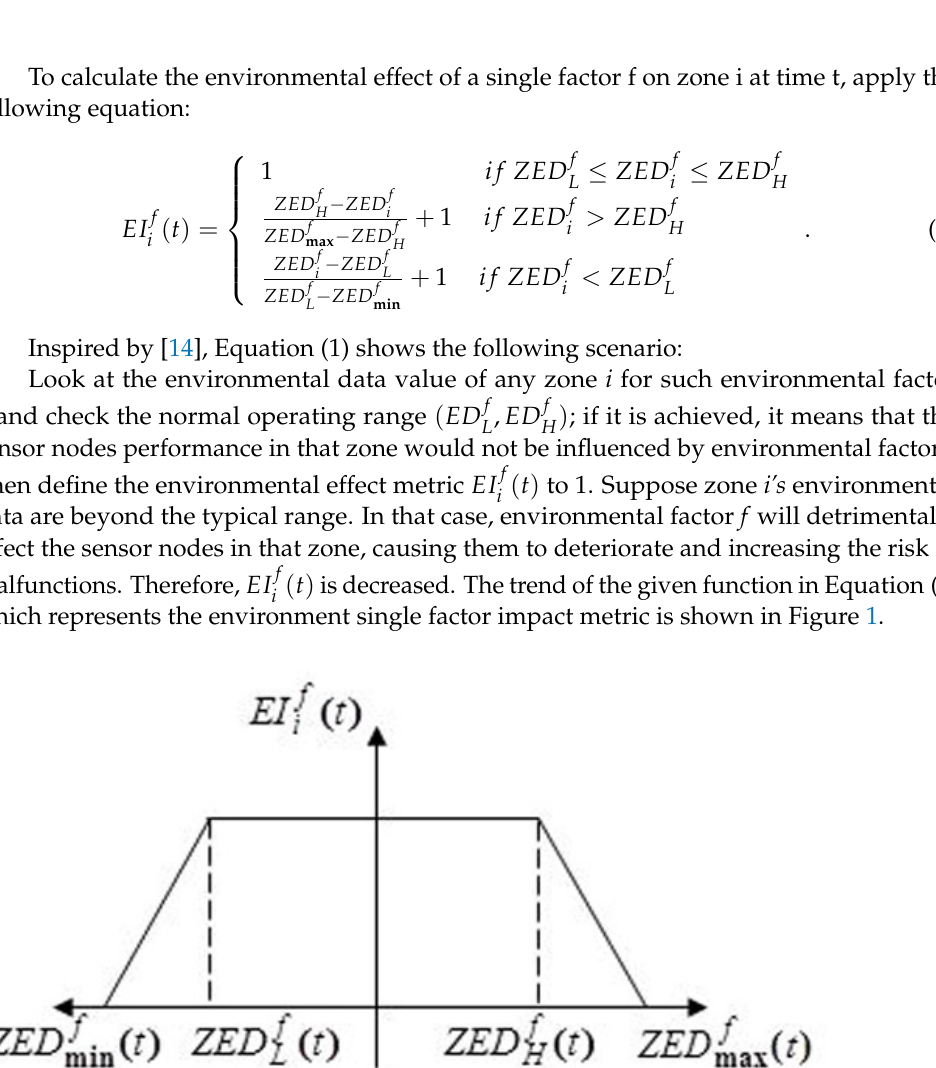
Figure 1. The curve of the single environmental impact metric function.